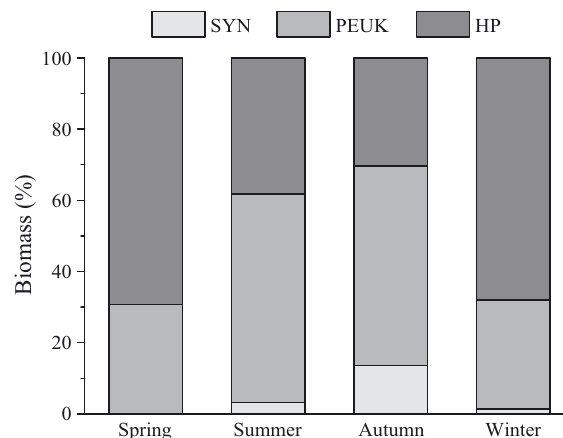
Fig. 5. Biomass contribution of Synechococcus (SYN), pico - eukaryotes (PEUK) and heterotrophic prokaryotes (HP) to picoplankton biomass in Sanggou Bay over 4 successive seasons